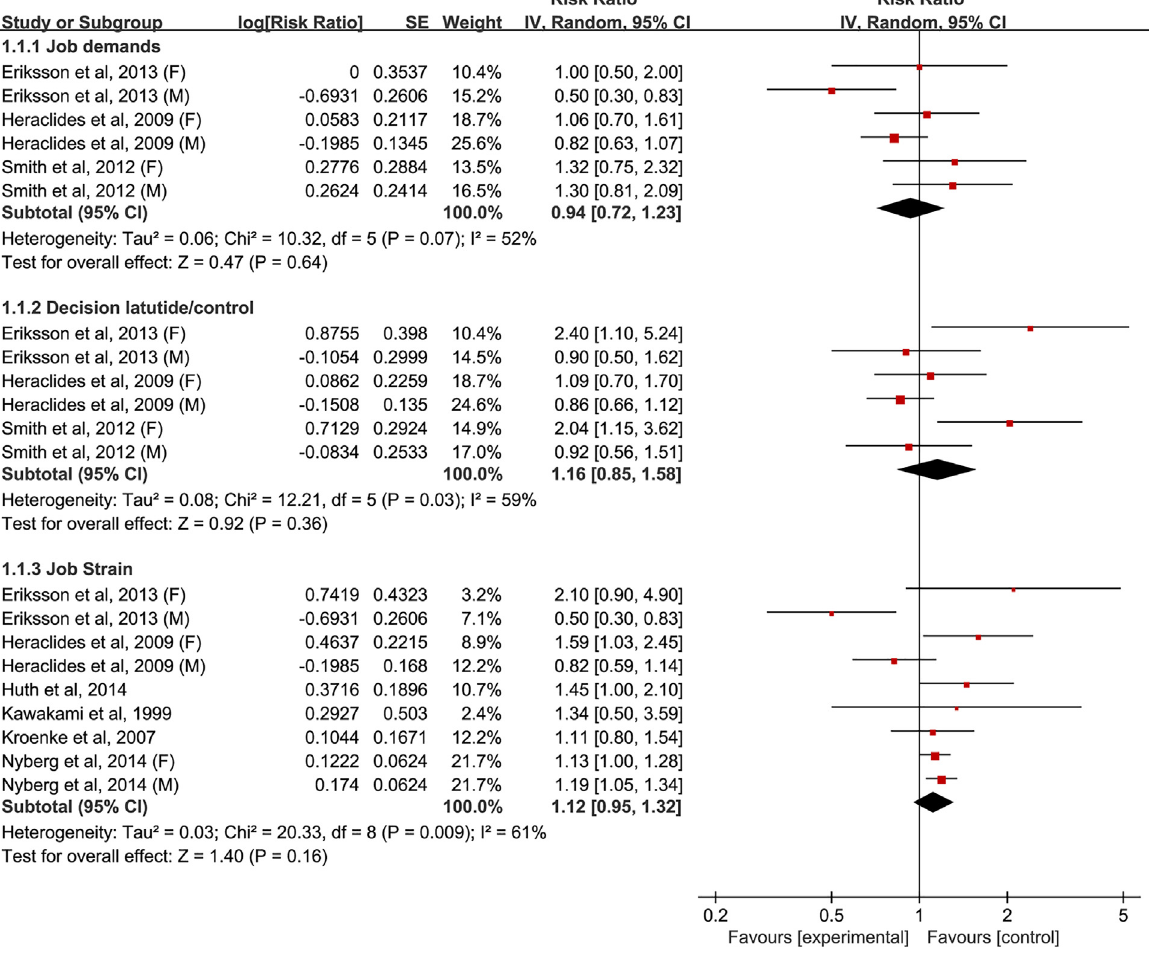
PLOS ONE | DOI:10.1371/journal.pone.0159978 August 11,